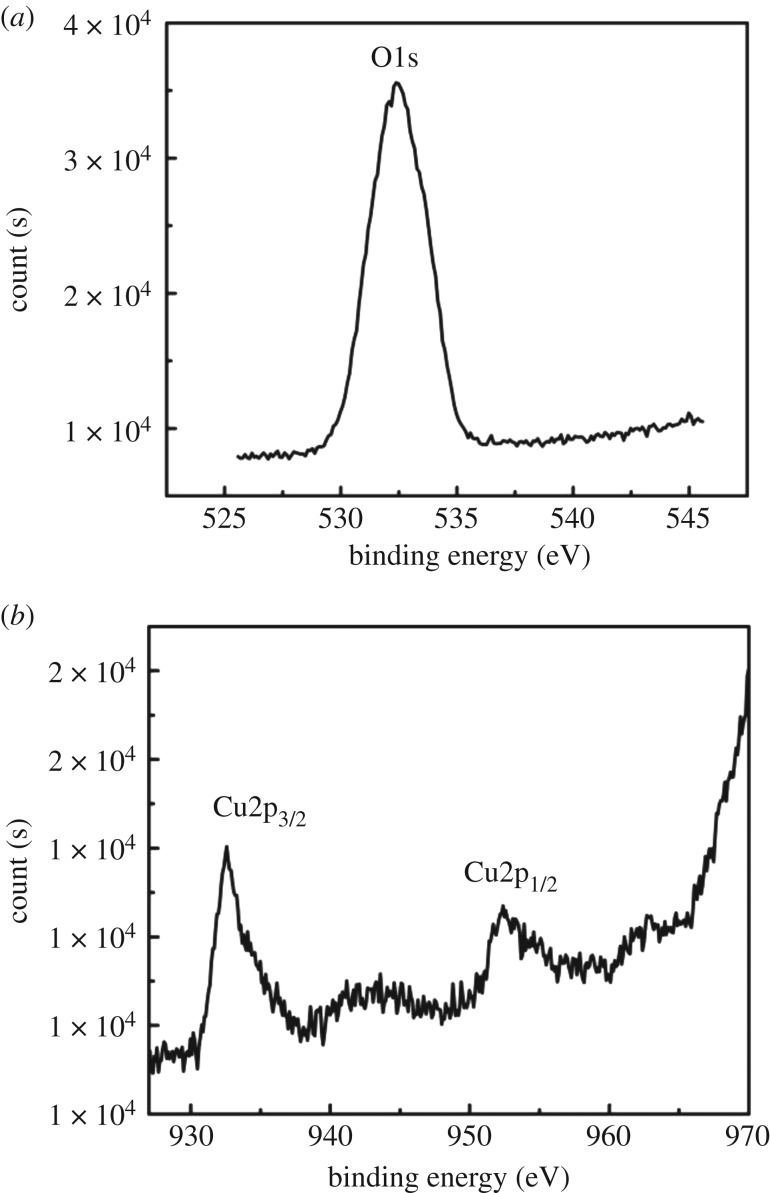
XPS spectra of Cu2O/HCFs. (a) O1s, (b) Cu2p3/2 and Cu2p1/2.